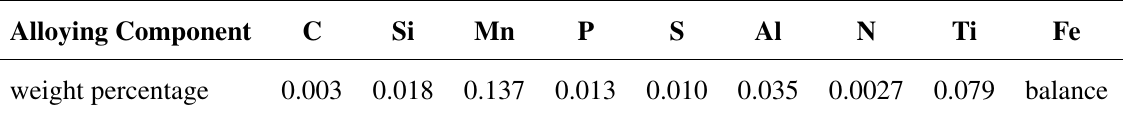
Table 1. Chemical composition (mass %) of DC06 according to DIN EN 10130:2006 [35], determined by the manufacturer (ThyssenKrupp Steel Europe) by means of an analysis of one single